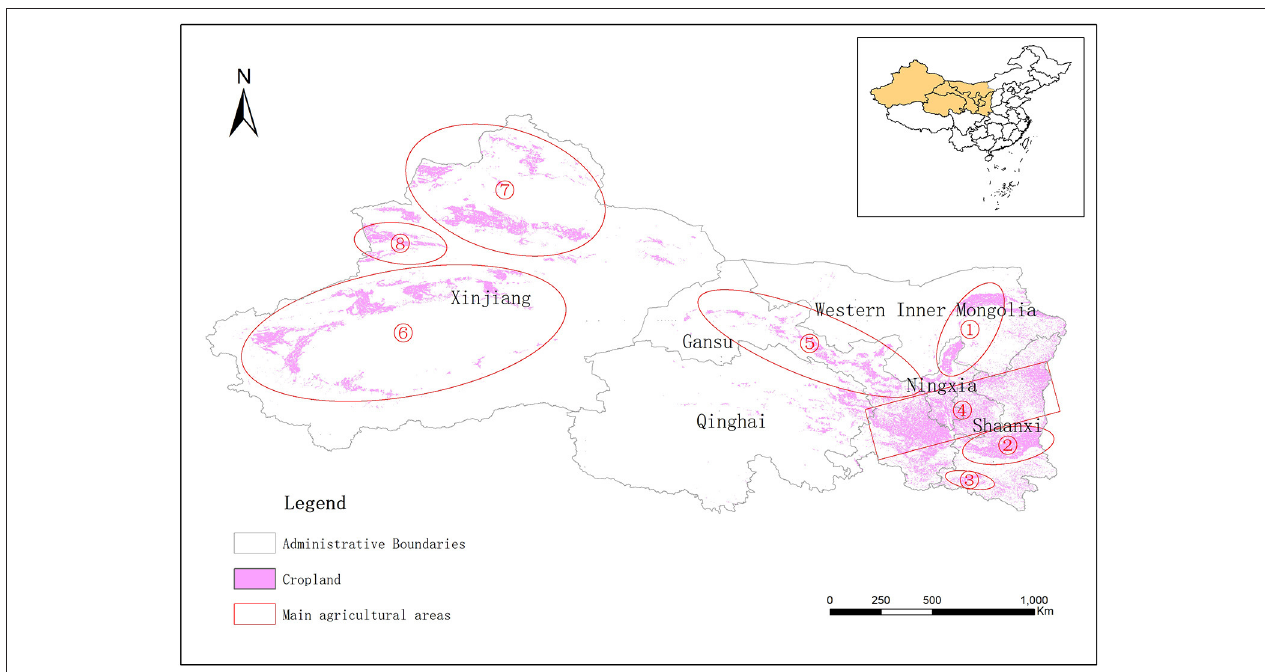
FIGURE 1 | Main agricultural areas in Northwest China. ‹ Hetao Plain, arid area; › Guanzhong Plain, semi-humid area; fi Hanzhong Plain, wet area; fl Loess Plateau, Semi-arid area; (cid:176) Hexi Corridor, arid area; – Tarim Basin, arid area; † Junggar Basin, arid area; ‡ Yili Valley, semi-arid area. Data obtained from the GlobeLand30 dataset (